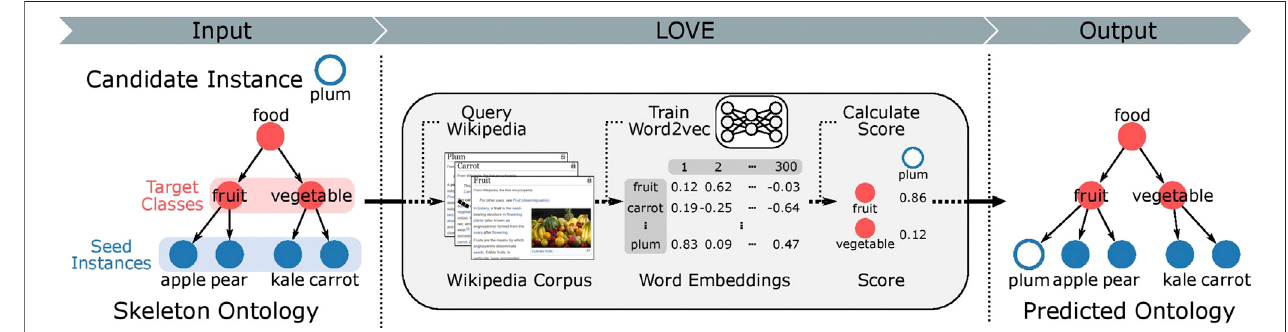
FIGURE1| OverviewoftheLOVEontologypopulationframework.Thehierarchicalstructureoftheontologyisorganizedasadirectedacyclicgraph,whereaclass connects to its parent classes through directed edges. Target class is the parent class of the food instances. Note that some classes are part of the hierarchical ontological structure and do not contain any instances. All class and instance labels are used to query the Wikipedia corpus, which is then used to train food word embeddings. The mappingfunctionthen uses the wordembeddings tomap thecandidate instances tothe target classes. All relations between theinstances and classes are of type “ is a. ” We compare the predicted ontology to the ground truth ontology and report the performance using precision (more information in the “ Methods ” section).